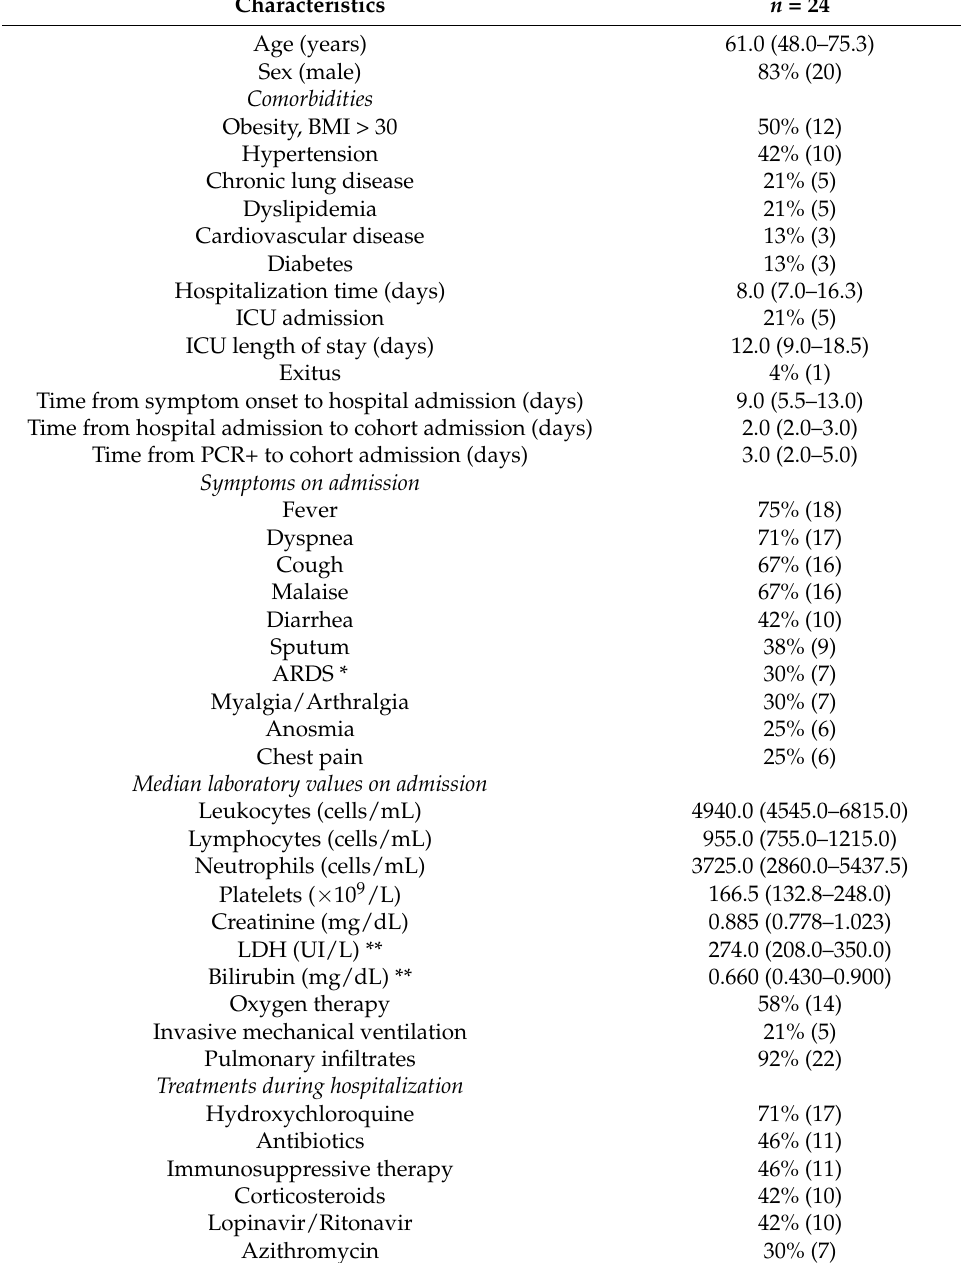
Table 1. Demographic and clinical characteristics of the study